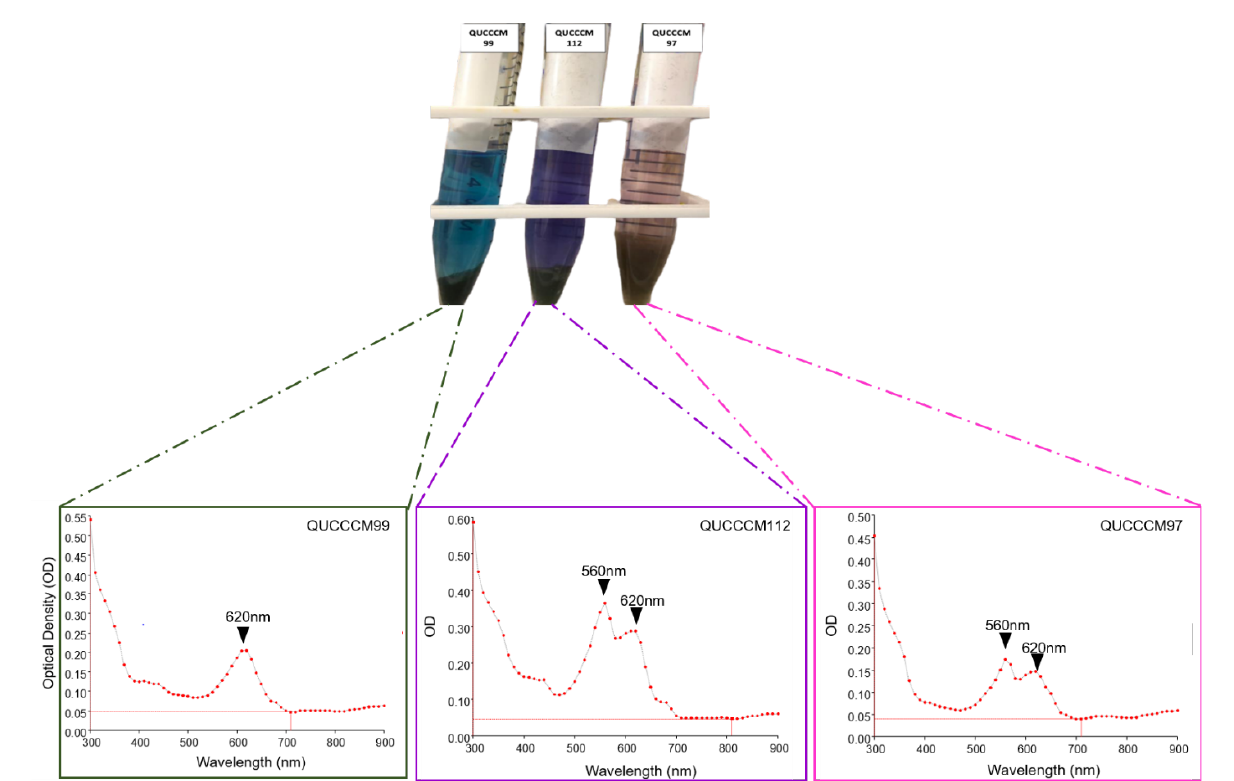
Figure 3. Aqueous extracts and the correspondent spectral scan of the strains Nostoc ellipsosporum (QUCCCM99), Desmonostoc danxiaense (QUCCCM112), and Roholtiella sp. (QUCCCM97). QUCCCM99 presented a high absorbance at 620 nm corresponding to maximum absorbance of the Phycocyanin while QUCCCM97 and QUCCCM112 presented two peaks of absorbance at 560 and 620 nm. These peaks correspond to the λ max of phycoerythrin and phycocyanin, respectively.